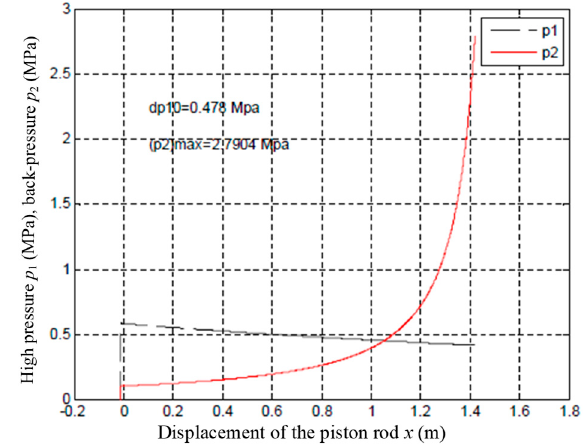
Figure 3. Relationship between the pressure and the displacement of the piston rod at the impact overload of 10 g .